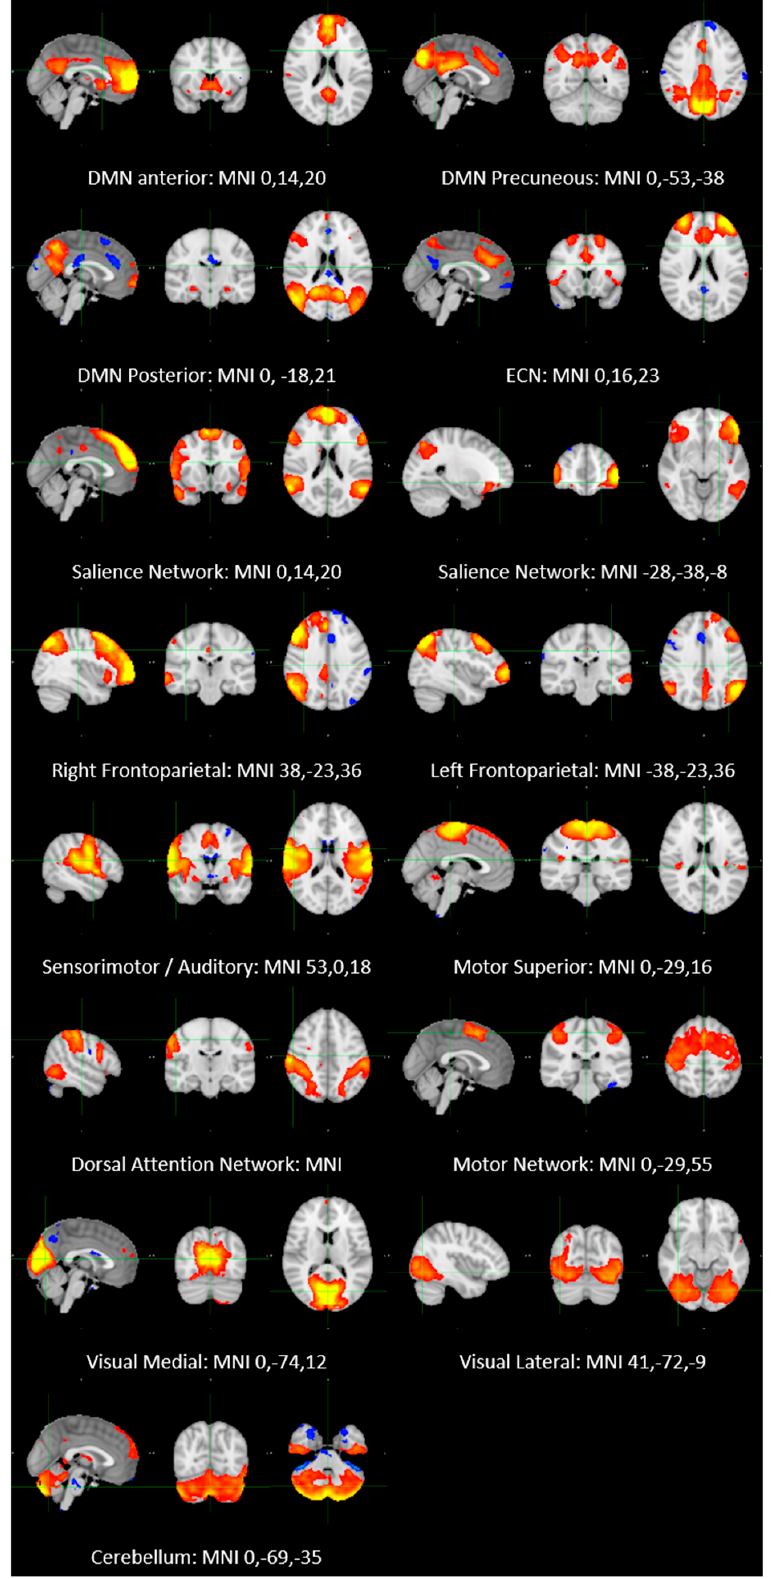
Figure 1. Resting state networks identified in the study. Axial, coronal and sagittal slices for the main resting state networks detected, overlaid onto the standard MNI brain. All maps were thresholded at Z =